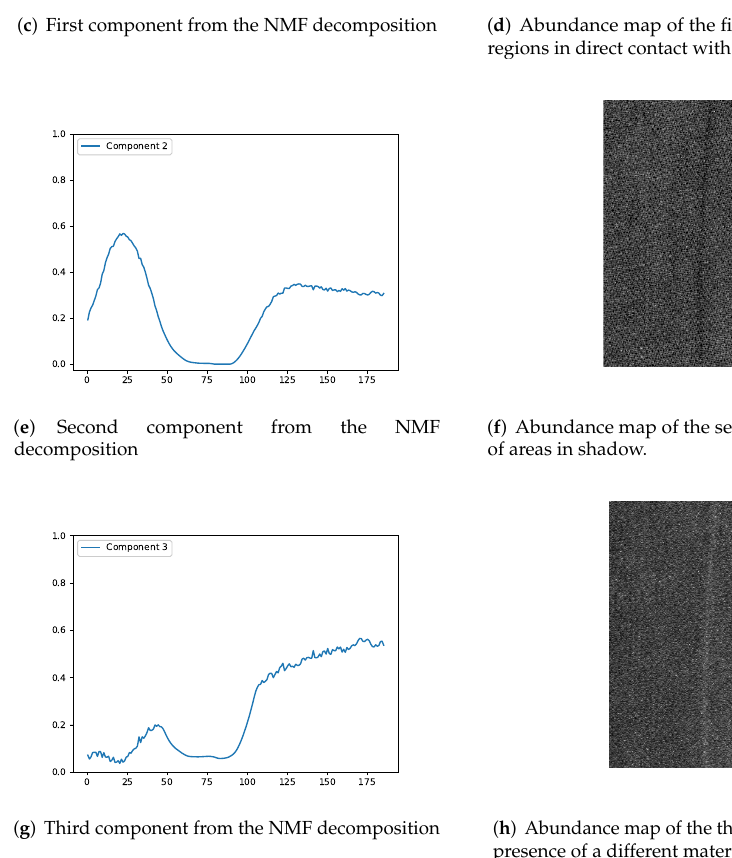
Figure 14. NMF-based decomposition of textile_22_cyan image in three components. The extracted components consist of areas under direct illumination, shadow areas and the presence of different materials in the textile